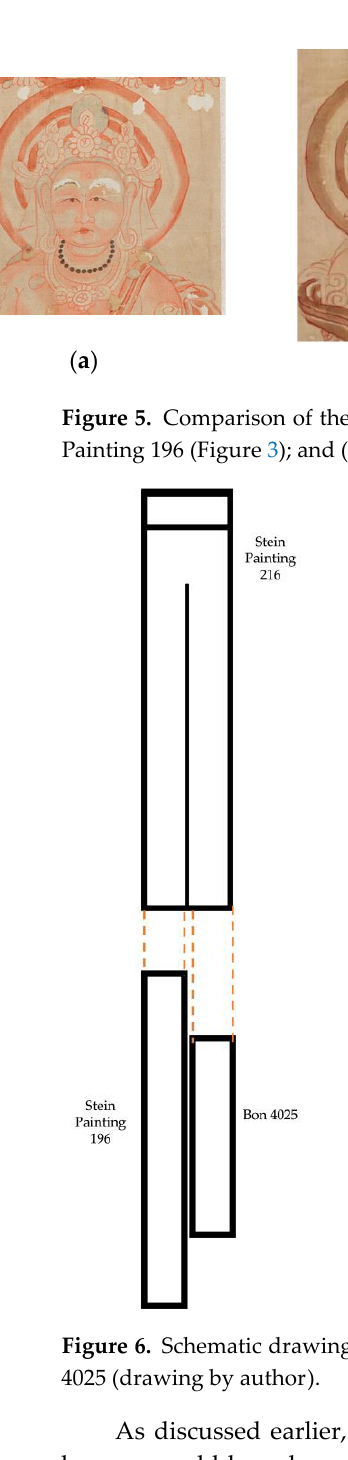
Figure 4. Long Banner of Bodhisattvas , 10th century CE, ink and colors on silk, H. 180.4 cm, W. 28.2 cm, Bon 4025, National Museum of Korea. Photograph licensed under Creative Commons, repro- duced with permission from National Museum of Korea, Seoul.